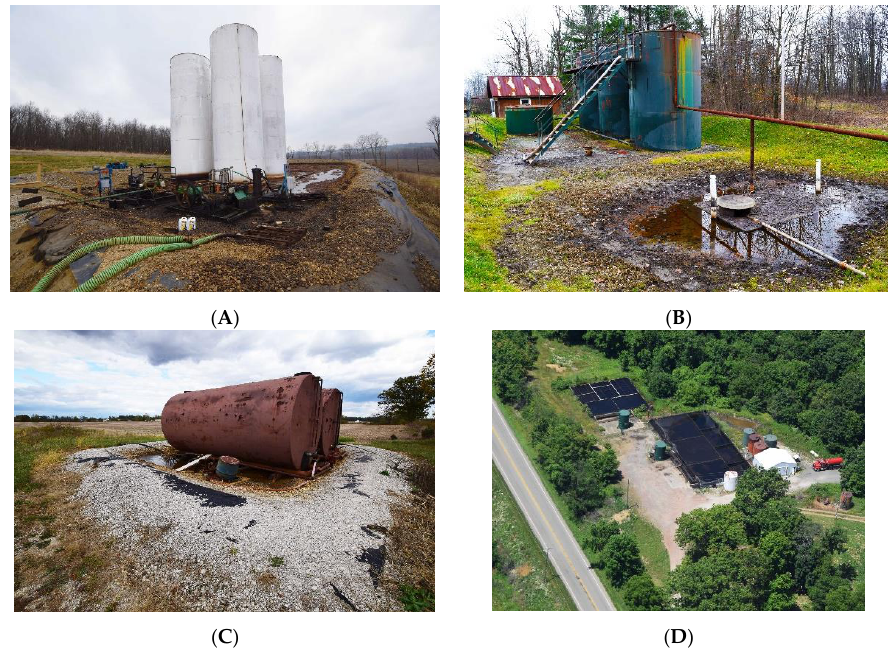
Figure 8. Class II injection wells—eastern Ohio. Danville ( A ), Knox ( B ), Morrow ( C ), and Stark ( D ) Counties.